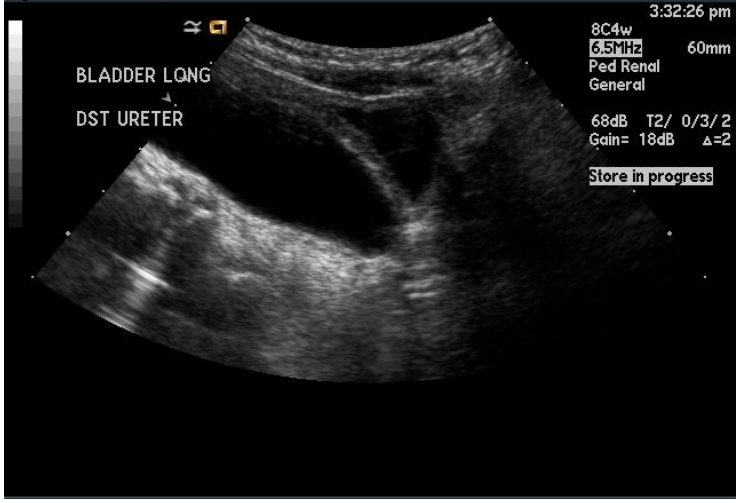
FIGURE 2. Ultrasound from obstructed megaureter demonstrating dilated distal ureter to tapered distal